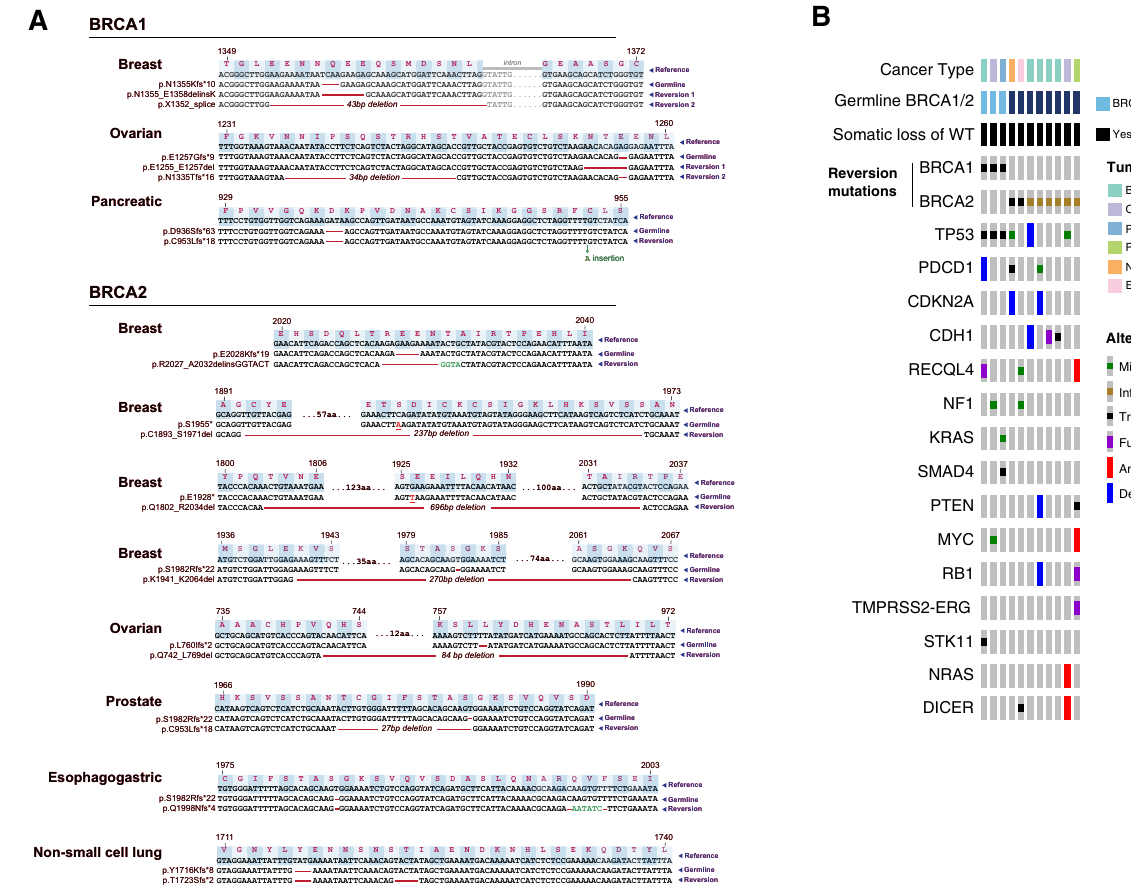
BRCA2 ( n =8) somatic reversion mutations. B Oncoprint showing clinical char- acteristics and somatic alterations for all patients with BRCA1/2 reversion